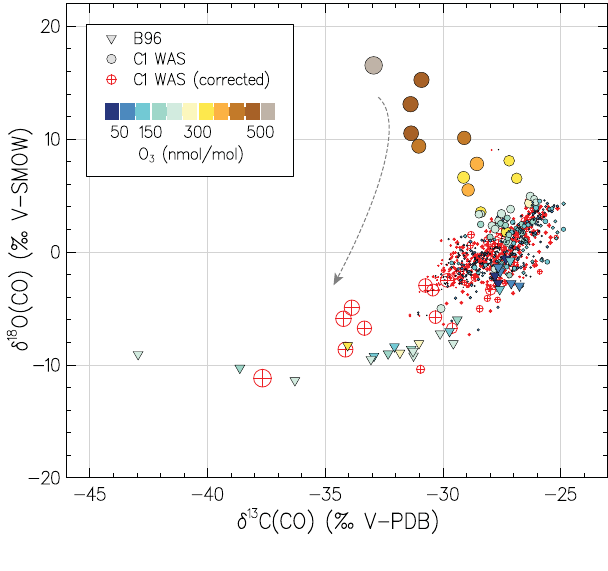
Figure 7. 18 O/ 16 O and 17 O/ 16 O isotope composition of CO mea- sured in C1. Triangles present the data from the remote SH UT/LMS obtained by Brenninkmeijer et al. (1996) (B96). Colour refers to the concomitantly observed O 3 abundances; note the extremely low [O 3 ] encountered by B96 in the Antarctic ozone-hole conditions. Filled and hollow circles denote the original and corrected (as ex- emplified by the dashed arrow) C1 WAS data, respectively, with the symbol size scaling proportional to the estimated contamination magnitude (see text for